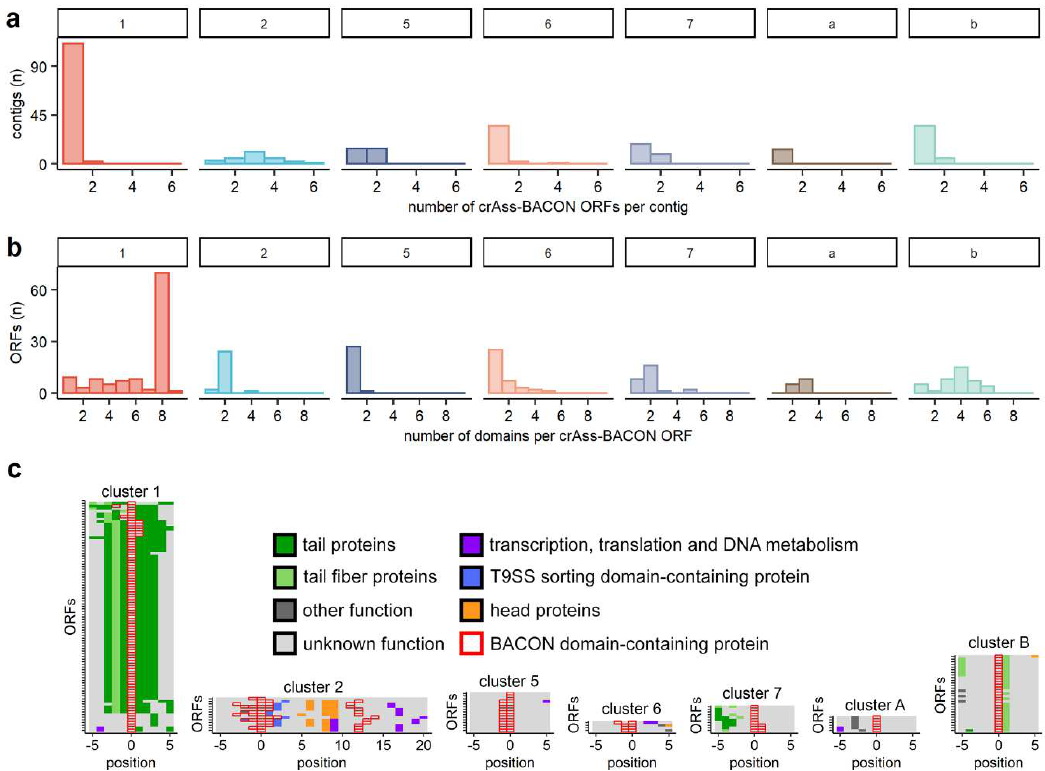
Figure 3. BACON-containing ORFs have diverse domain architectures and genomic neighbourhoods. Histograms of ( a ) the number of BACON domains per ORF and ( b ) the number of BACON domains containing ORFs per contig show the diversity in domain architecture between clusters. ( c ) The genomic neighbourhood of crAss-BACON ORFs. Note that the ORFs containing crAss-BACON tandem arrays (clusters 1,7 and B) are flanked by tail proteins. Only contigs with more than 10 ORF predictions and at least one homolog with a predicted function other than “hypothetical protein” are shown (cluster 1: n = 88/113 contigs are shown, 2: n = 13/27, 5 = 15/28, 6 = 4/38, 7 = 10/27, A = 6/13, B = 29/40).